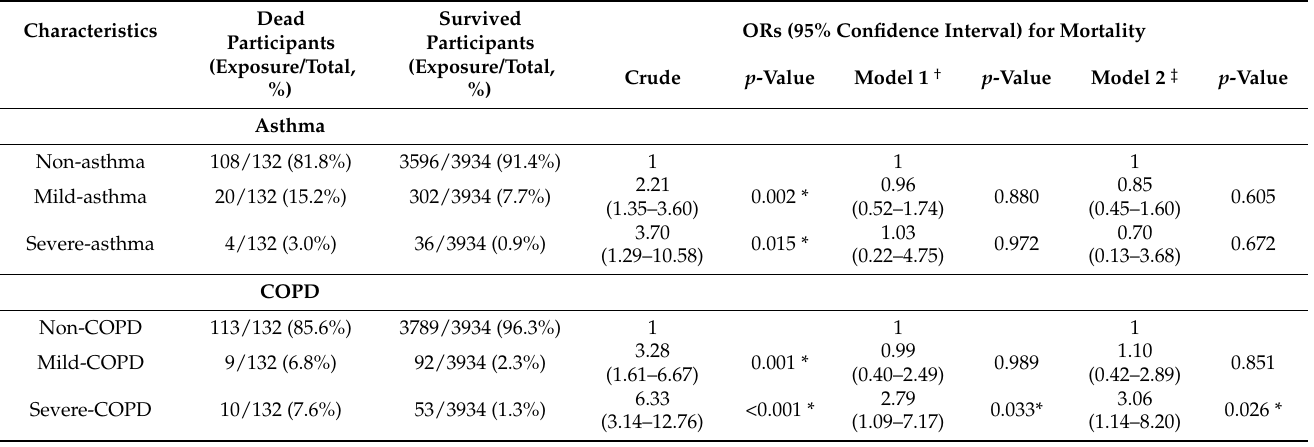
Table 4. Crude and adjusted odds ratios of asthma and COPD for mortality in COVID-19